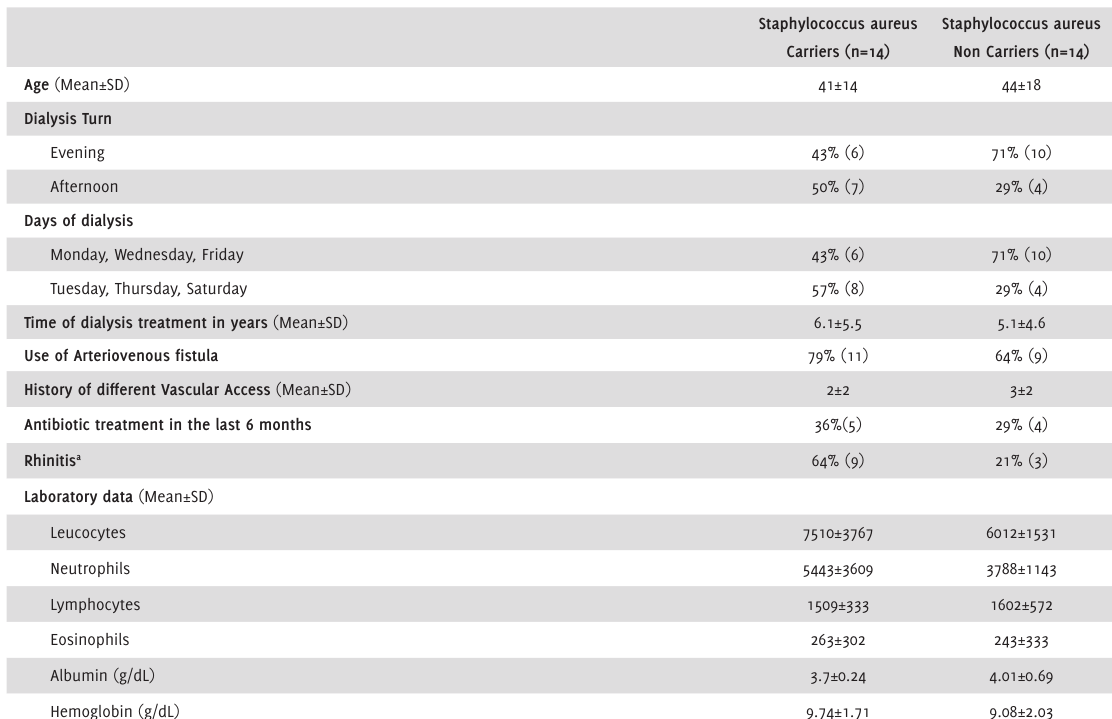
Table 3. Demographics of Hemodialyzed Patients